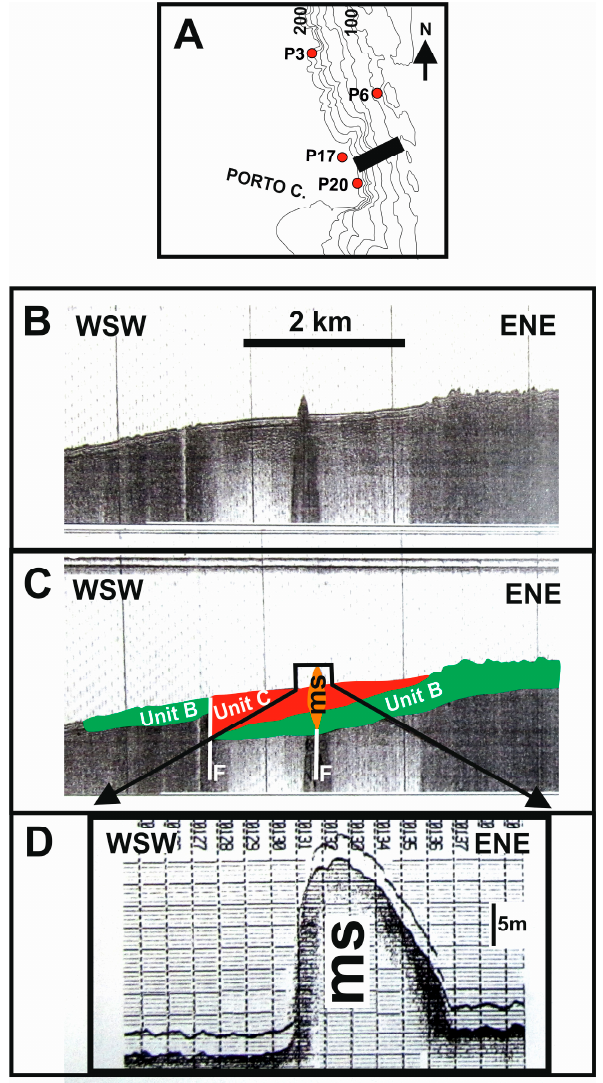
Figure 21. (A–D). Seismic reflection profile obtained at the Porto canyon head latitude. ( A ) Localization of the profile; ( B ) Seismic profile without interpretation; ( C ) interpreted seismic profile with localization of the metamorphic structure (ms); and ( D ) Detail of the bathymetric profile of the metamorphic structure. F corresponds to the interpreted faults. Unit B corresponds to a Mesozoic rock unit. Unit C corresponds to a Cenozoic rock unit (interpreted as dolomitized detrital limestones). Adapted from [13].